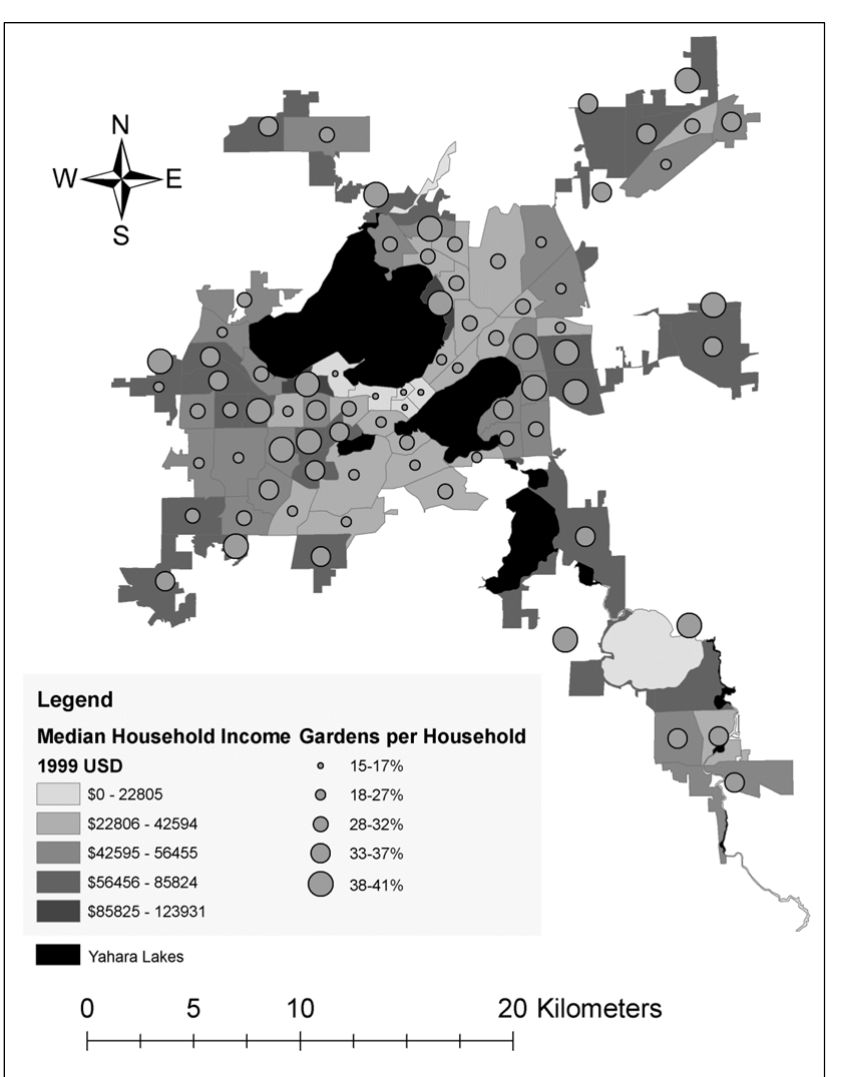
Figure 9. Home Garden Participation with Median Household Income by Census Tract Likelihood of participation increases as median household income